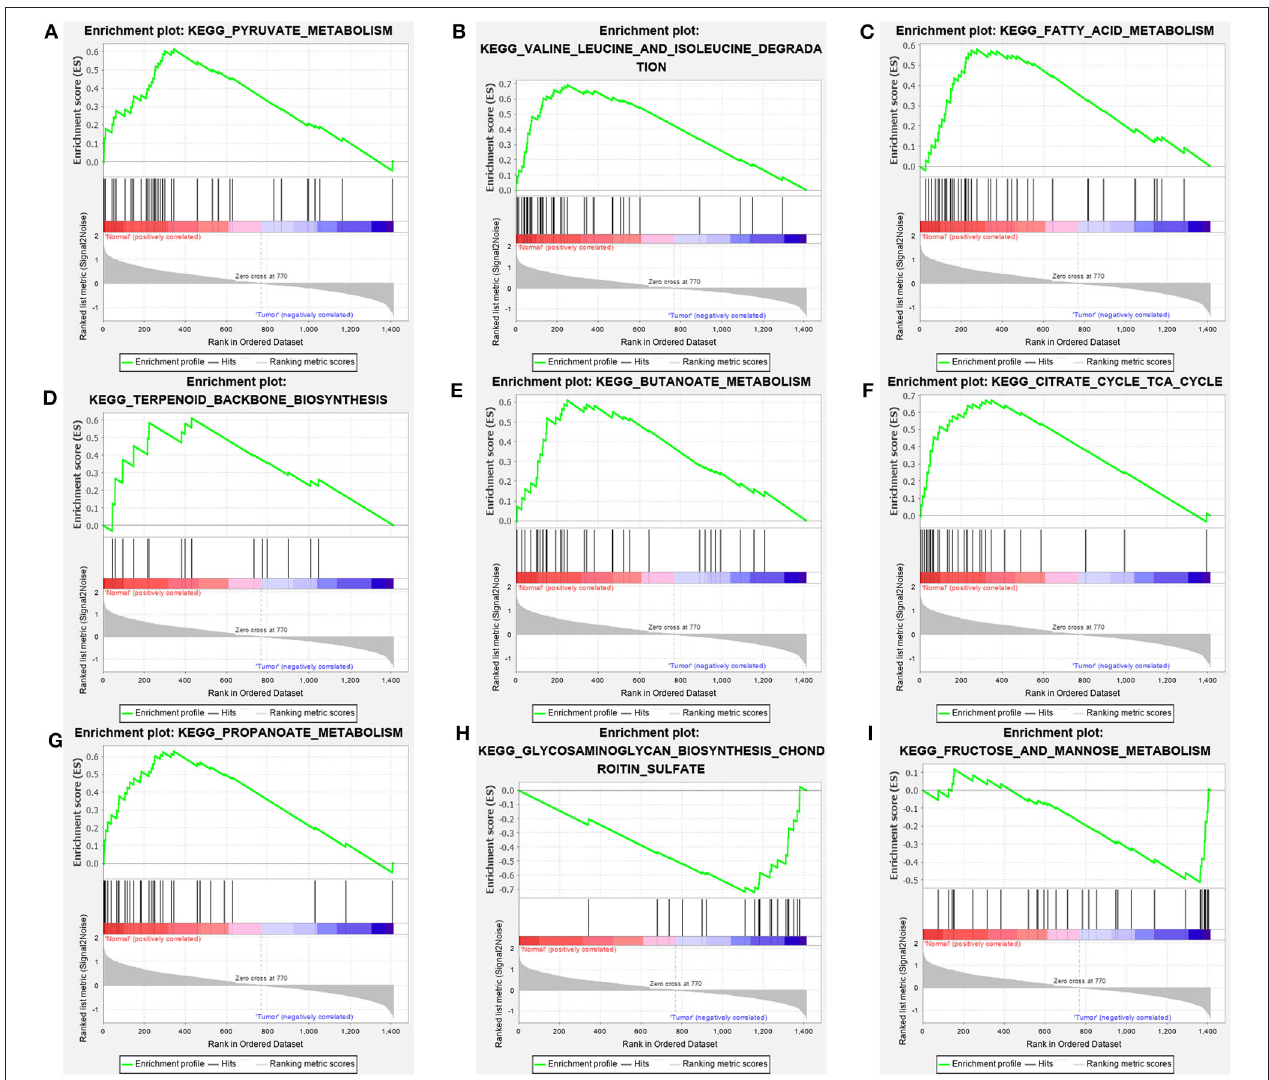
FIGURE 2 | Metabolic pathways significantly enriched in normal groups (A–G) and ccRCC groups (H,I) based on GSEA of TCGA